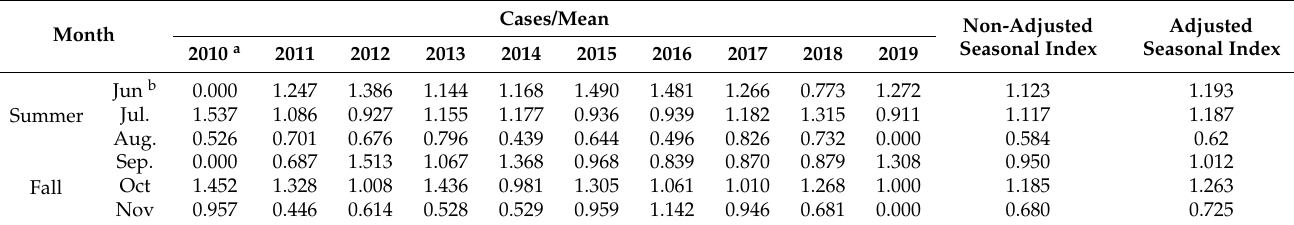
a : the rows represent “year”. b : the columns represent June, July, August, September, October,